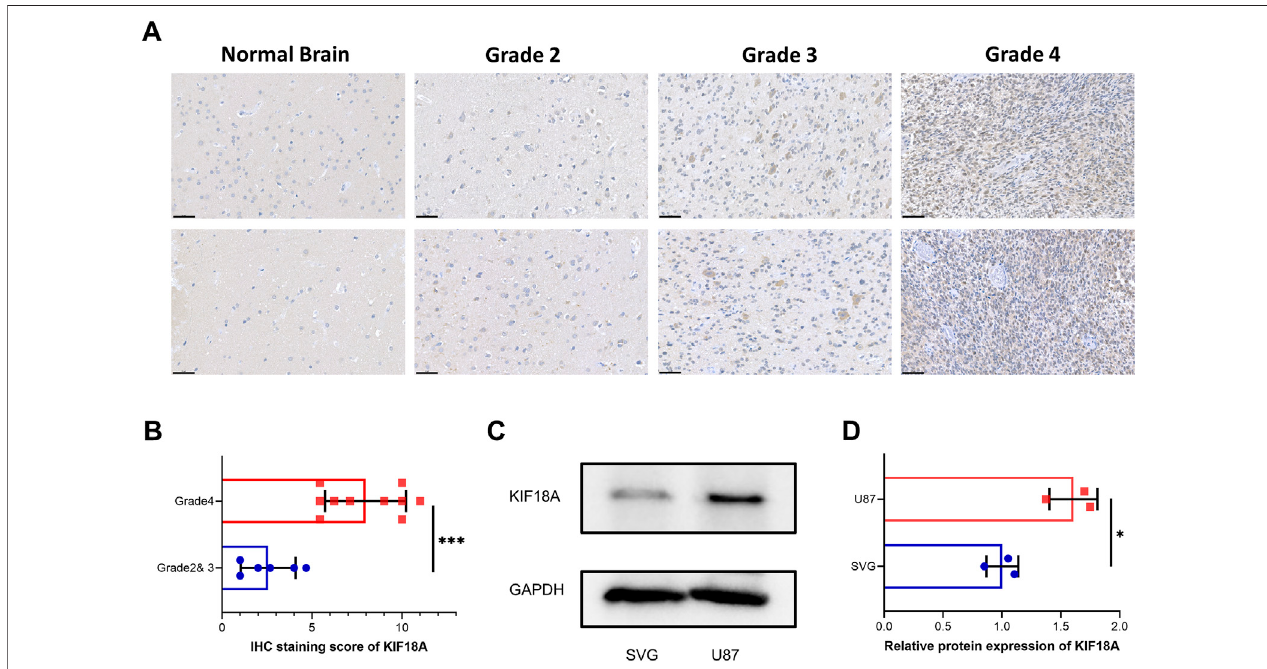
FIGURE7| ValidationofKIF18A expressioninclinicalsamplesandcelllines. (A) Con fi rmationofKIF18Aexpression usingimmunohistochemicalstaininginnormal brainand glioma tissues.Scare bars, 50 μ M. (B) IHC stainingscoreofKIF18A in gliomawithdifferentgrade. (C) Examination oftheexpression ofKIF18A in theU87and SVG cell line by western blot. (D) Quantitative data of KIF18A in the U87 and SVG cell line. (* p < 0.05, ** p < 0.01, *** p < 0.001).